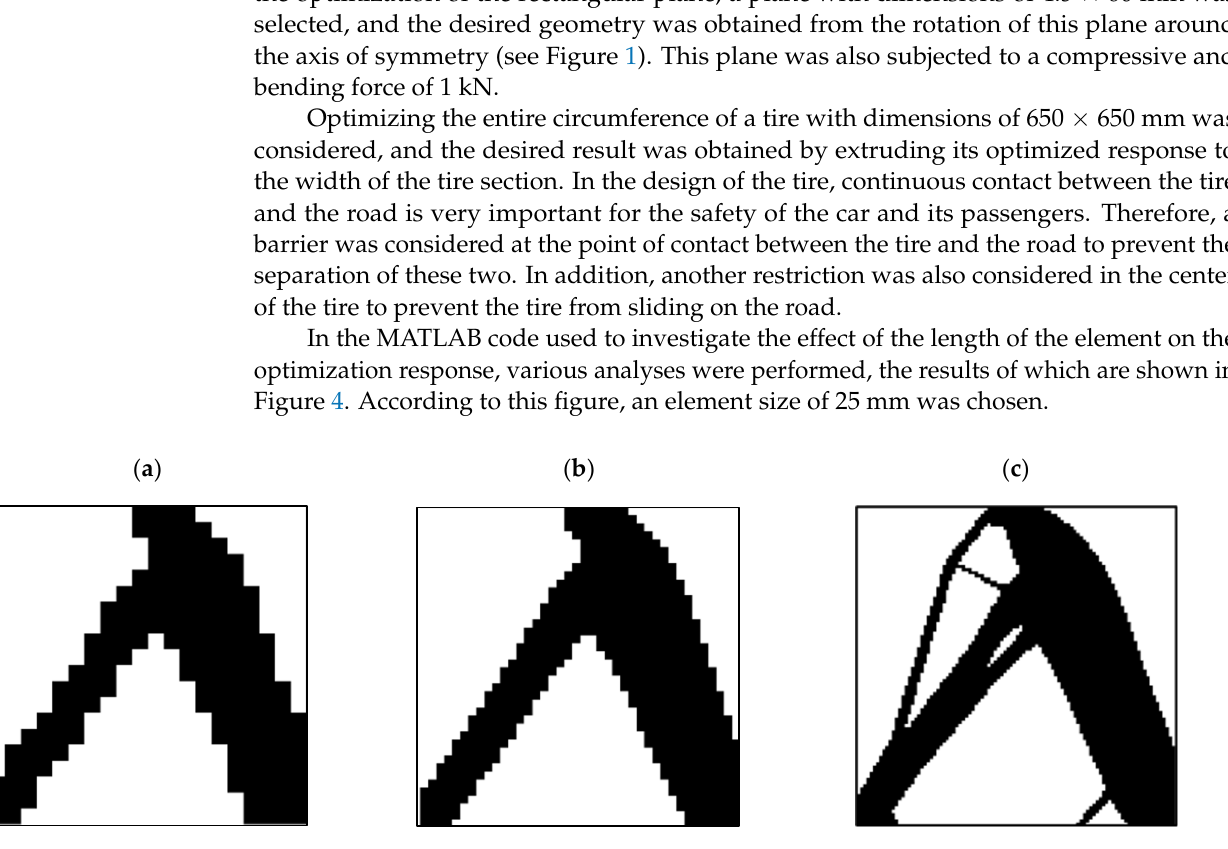
Figure 4. The effect of element size on the optimization response: ( a ) 50, ( b ) 25, and ( c ) 10 (mm).